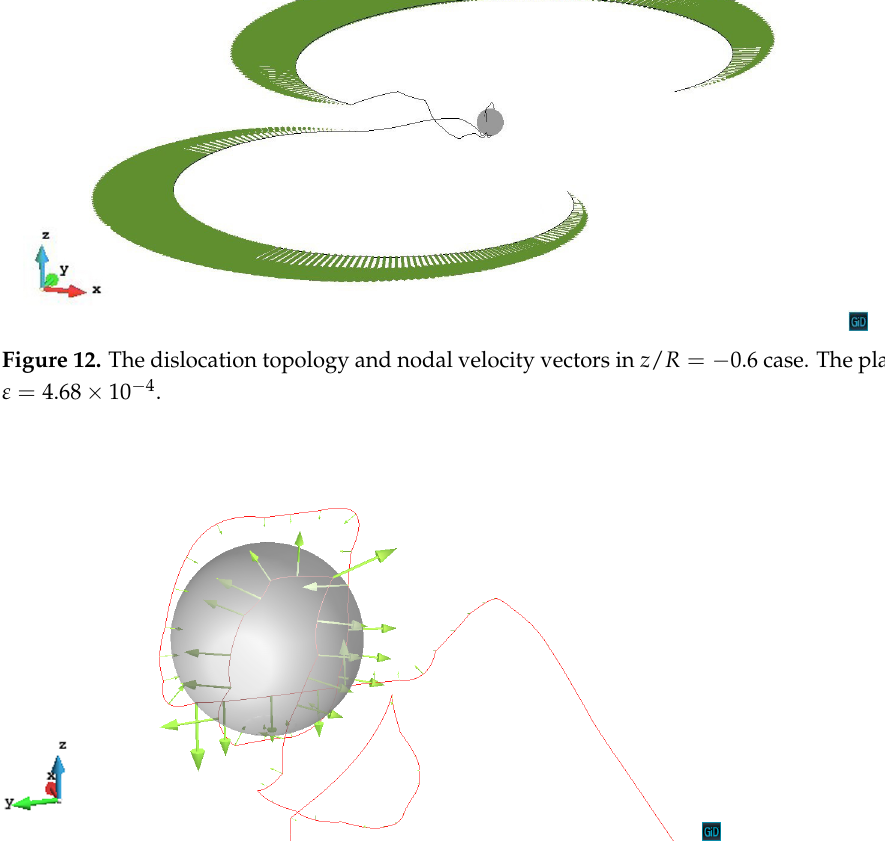
Figure 13. The dislocation nodal PK force vectors around the precipitate in z / R = − 0.6 case.